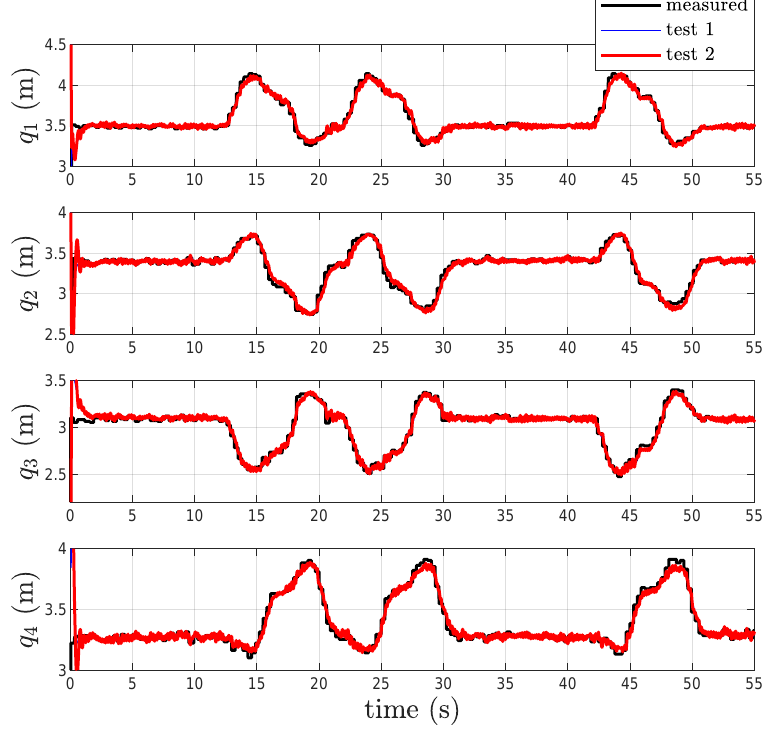
Figure 4. Measured and estimated distances q i in Test 1 and Test 2